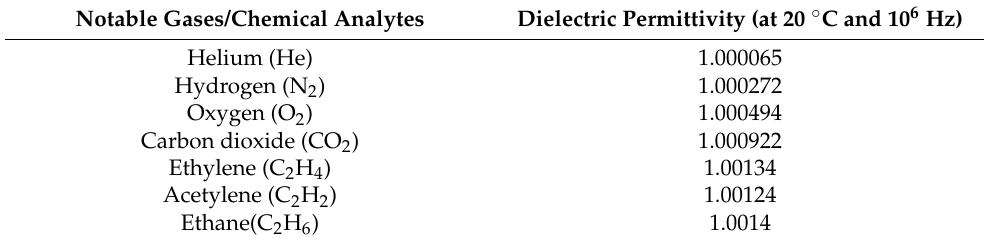
Table 1. Comparison of dielectric permittivity of notable gases/chemical analytes (Source: [37] and [39]). Notable Gases/Chemical Analytes Dielectric Permittivity (at 20 ◦ C and 10 6 Hz) Helium (He) 1.000065 Hydrogen (N 2 )